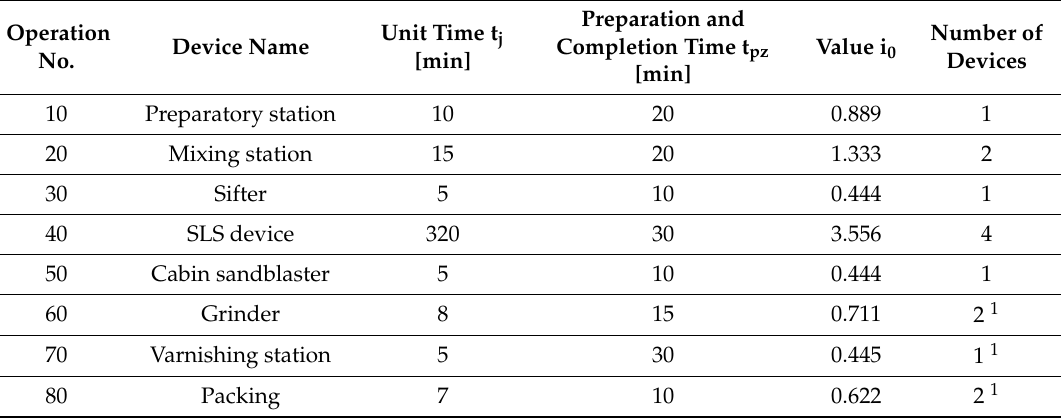
Table 1. Sequence of technological operations for product X with the calculated i 0 number of machines and devices necessary to implement the production plan.